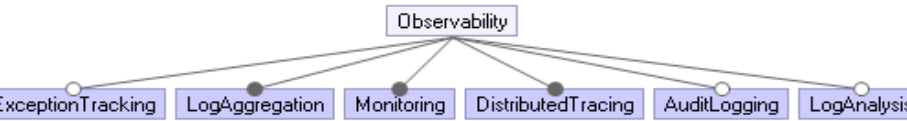
Figure 8. Feature diagram of observability.